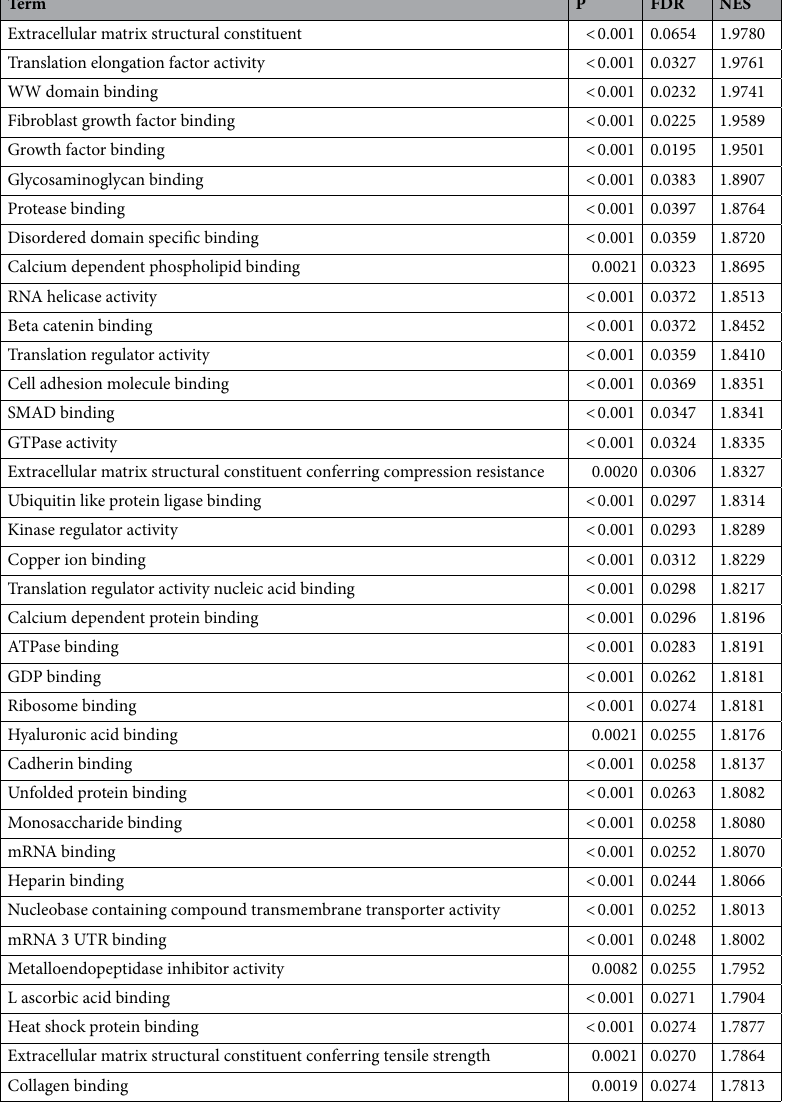
Table 5. The GSEA of CD63 for molecular